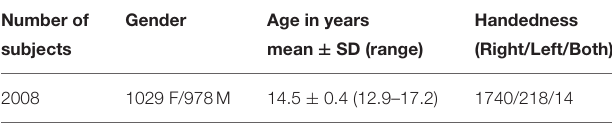
TABLE 1 | Characteristics of the studied population. Number of Gender